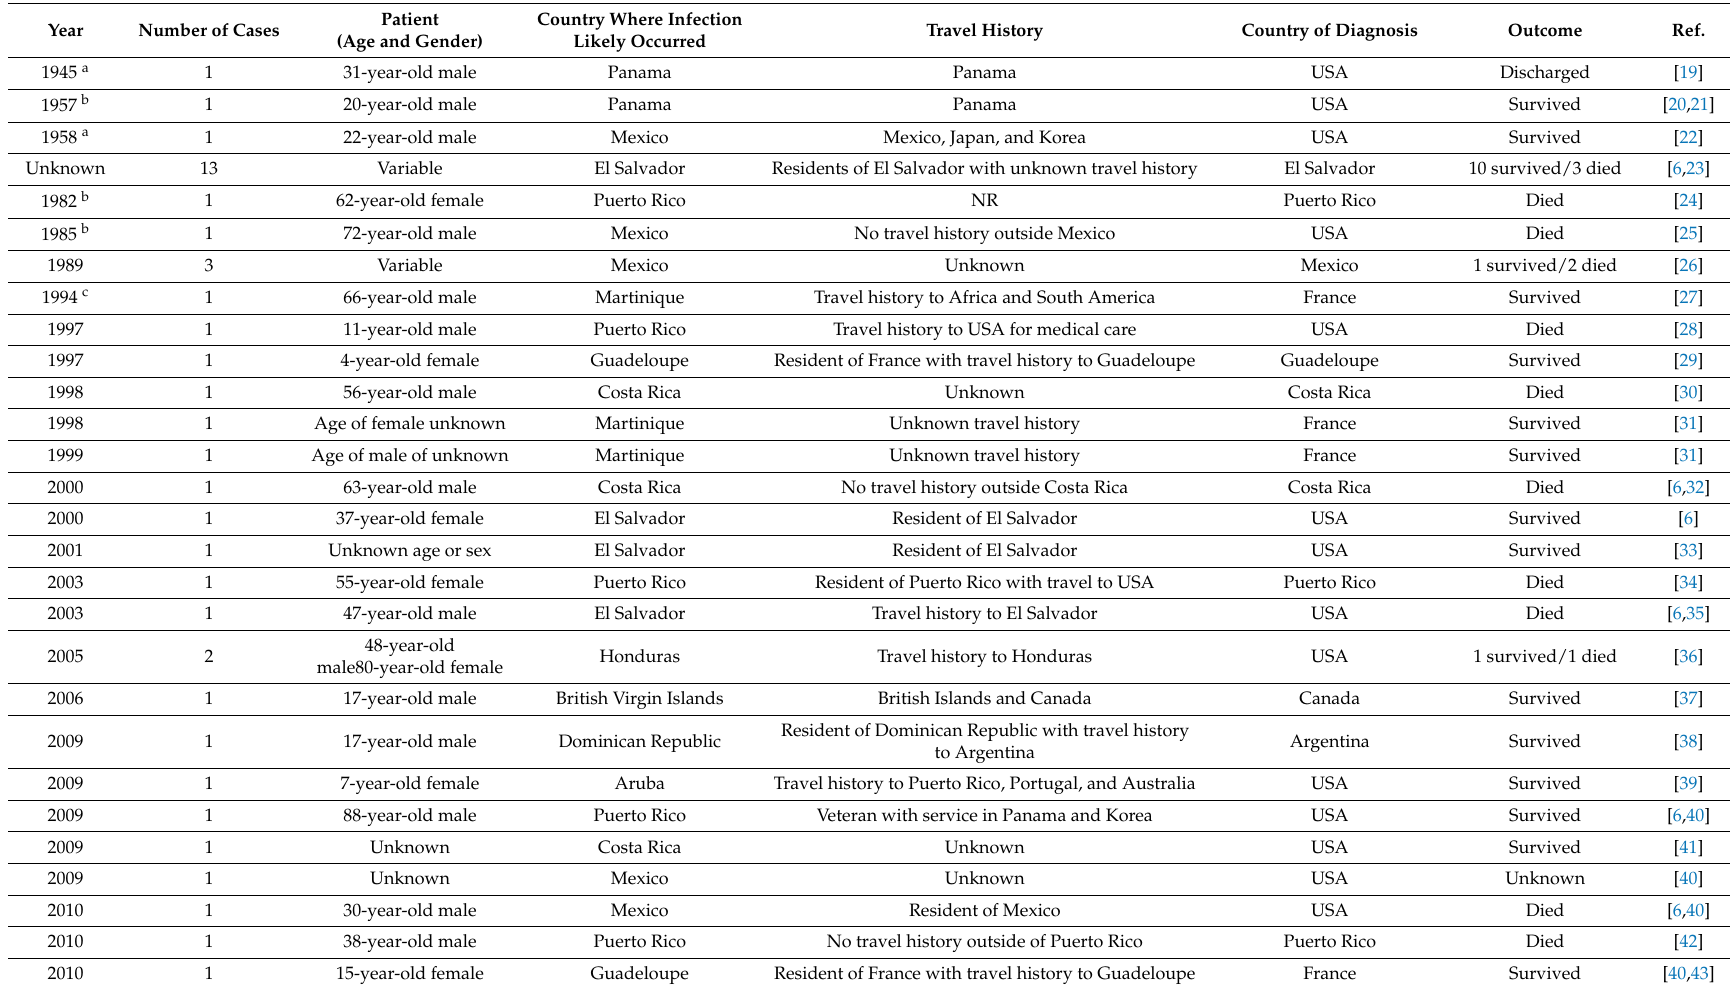
Table 1. Summary of published melioidosis cases in Mexico, Central America, and the